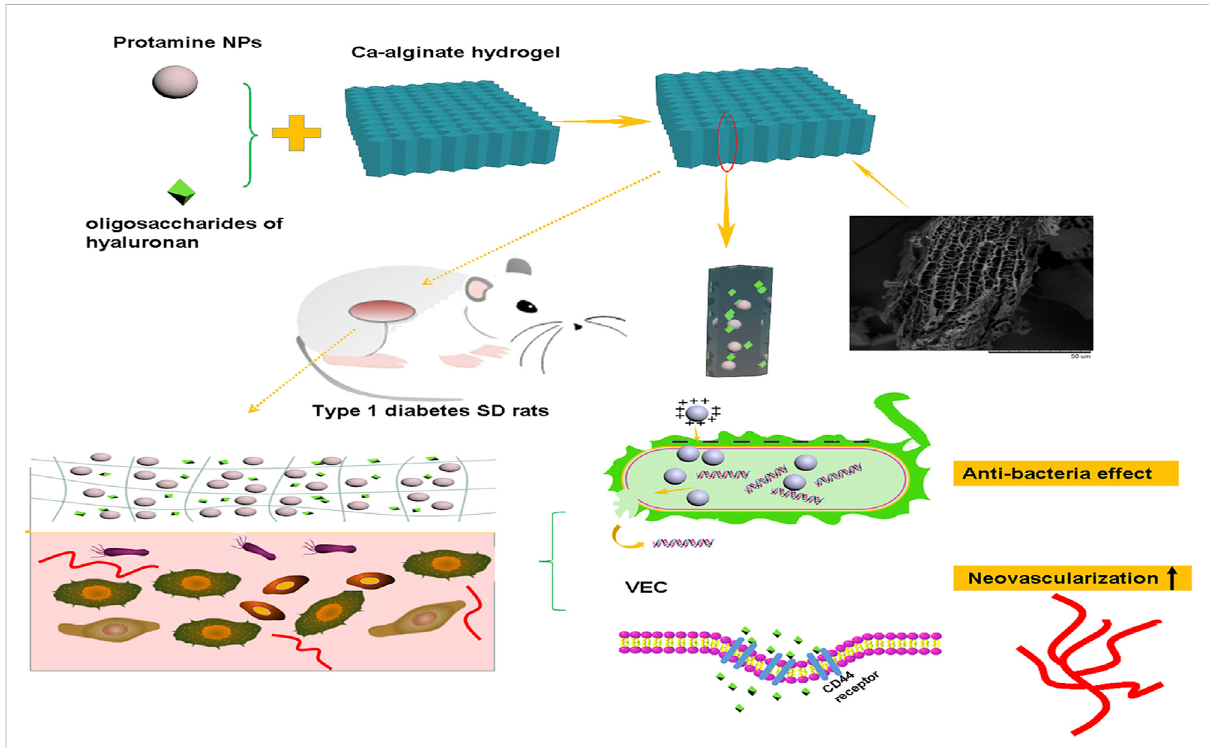
FIGURE 4 Application of a calcium alginate gel loaded with protamine nanoparticles and hyaluronan oligosaccharides in skin wound healing of type 1 diabetic rats. Reproduced from (Wang T. et al., 2019), with permission from Springer Nature.